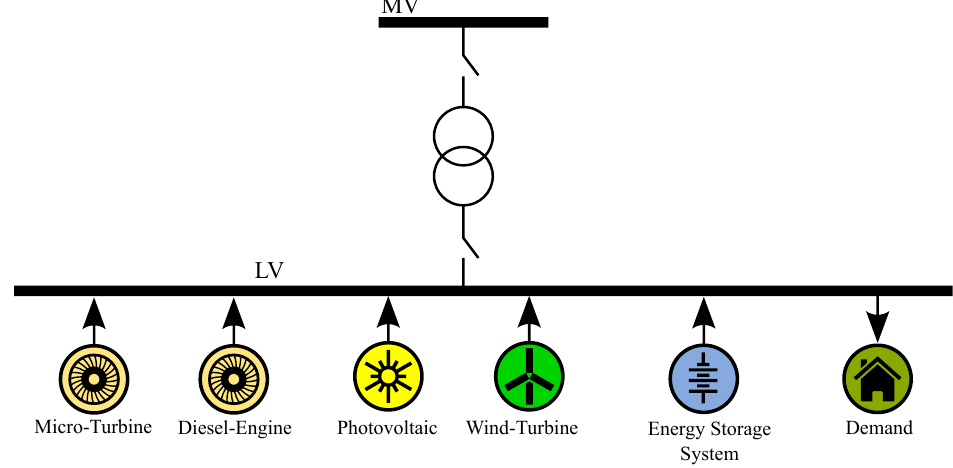
Figure 1. Structure of the microgrid